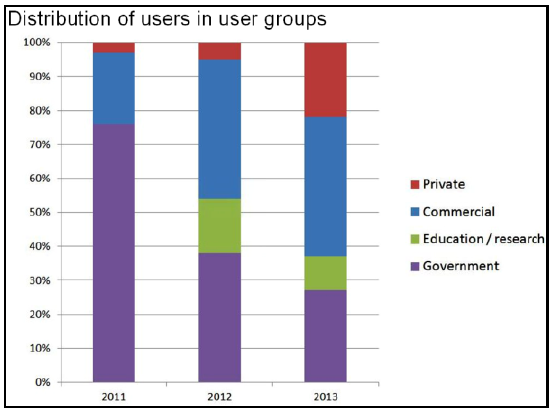
Figure 1. The users of the BRT separated in user groups